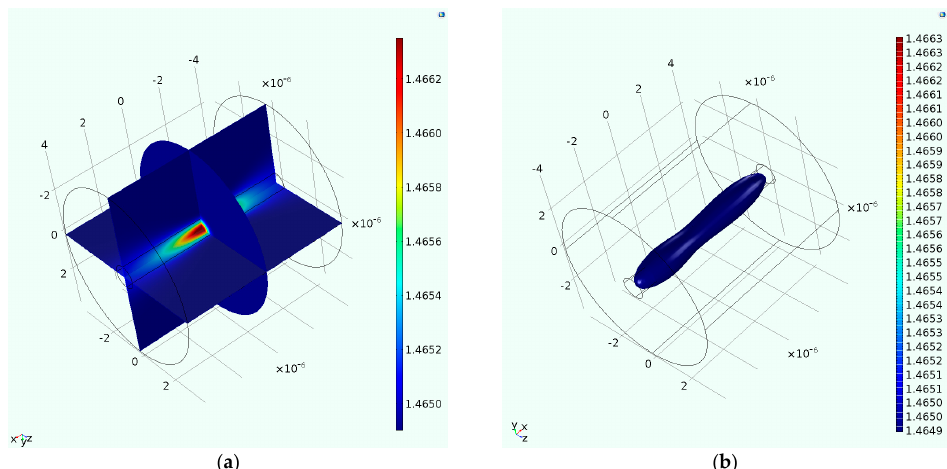
Figure 5. ( a ) A multi-slice plot of the induced refractive index profile; ( b ) An isosurface plot illustrating specified contours of the induced refractive index.